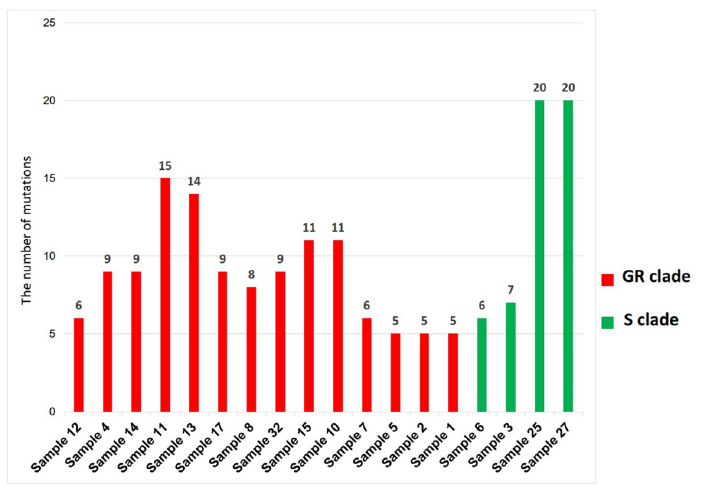
The most common nucleotide substitution detected (see S1 Table) was from cytosine to thy- mine (52/128 mutations), followed by guanine to thymine (36/128 mutations) and thymine to cytosine (10/128 mutations). All the shared mutations were homozygous. We observed one unique frameshift mutation (21574; c.13delC), seven shared mutations (G21850T, G22335T, A23403G, G23438T, G23593T, A24078G and G24410C), five unique (T22020C, T22478C, G22484T, C23634T and G24872T) missense mutations, two shared (G21724A and T25219G) and five unique (A23503T, C23758T, C24023T, G24199T and C24442T) synonymous muta- tions and five unique (A29676G, G29692T, C29708T and C29733T) with large deletions